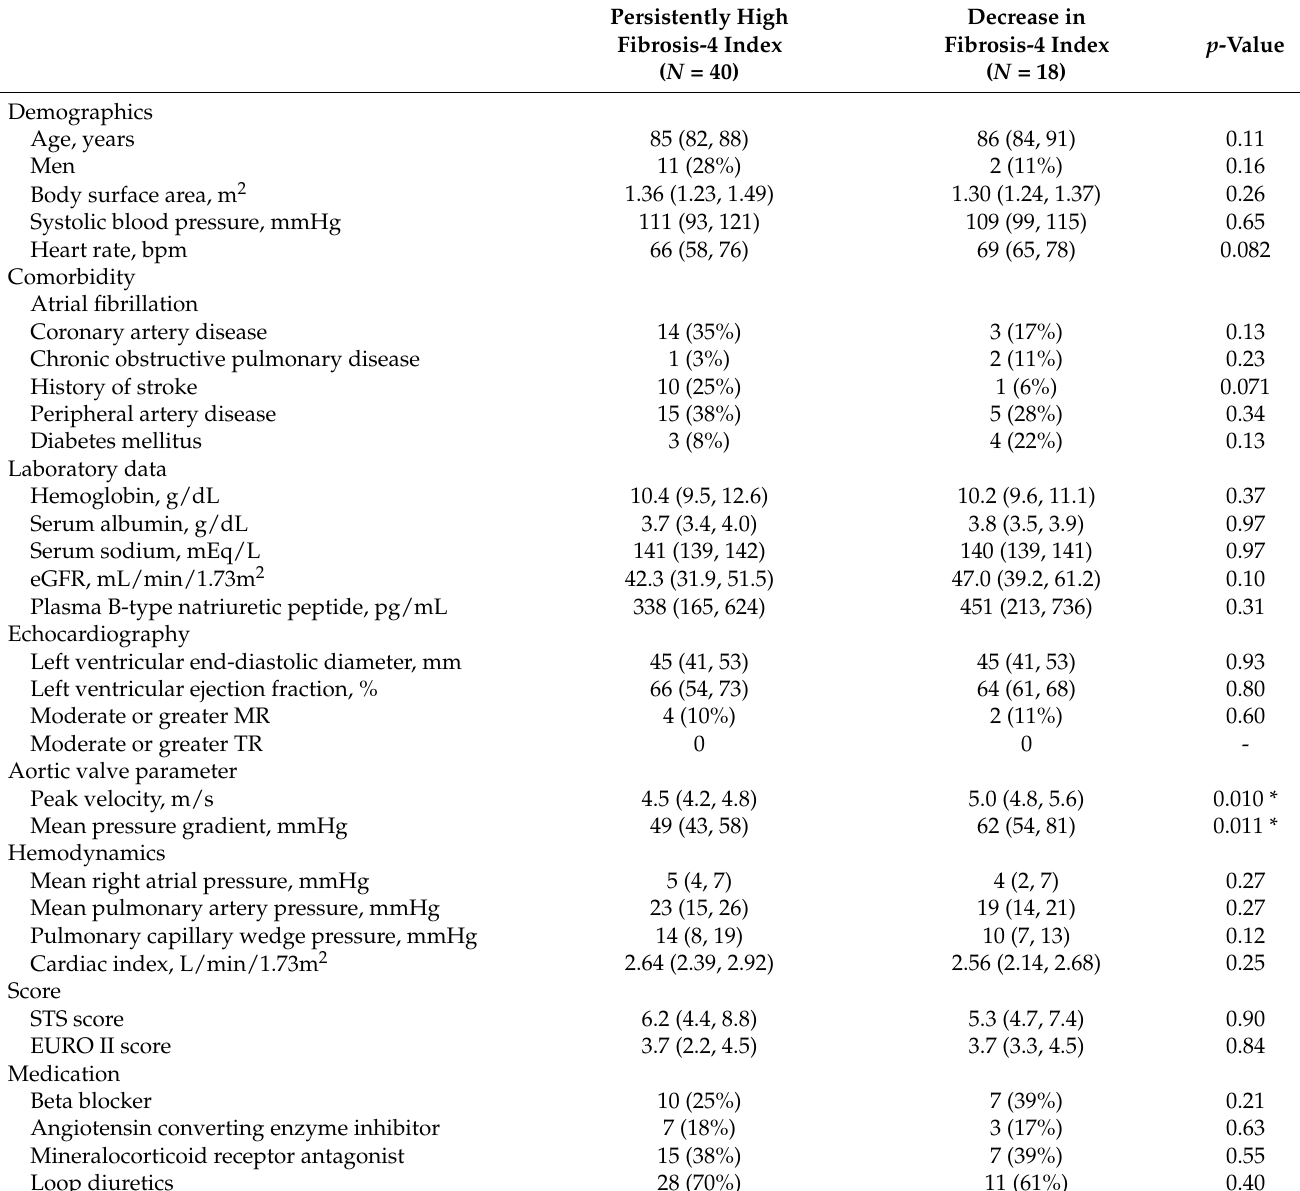
Table 4. Baseline characteristics among those with a high baseline fibrosis-4